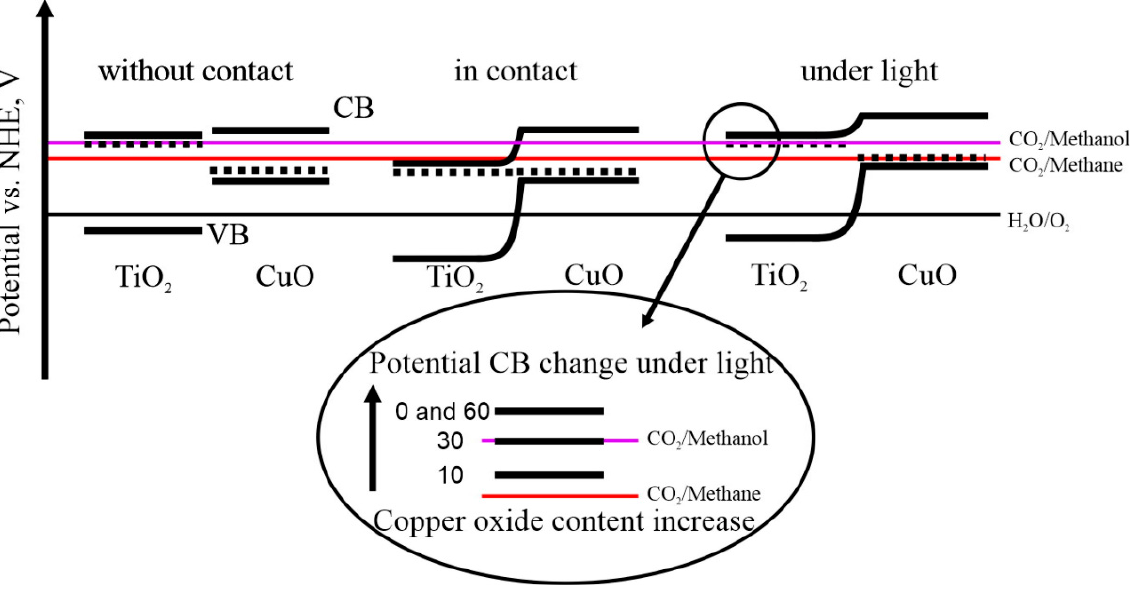
Figure 4. Energy band bending model in NTs/Cu x O composites.